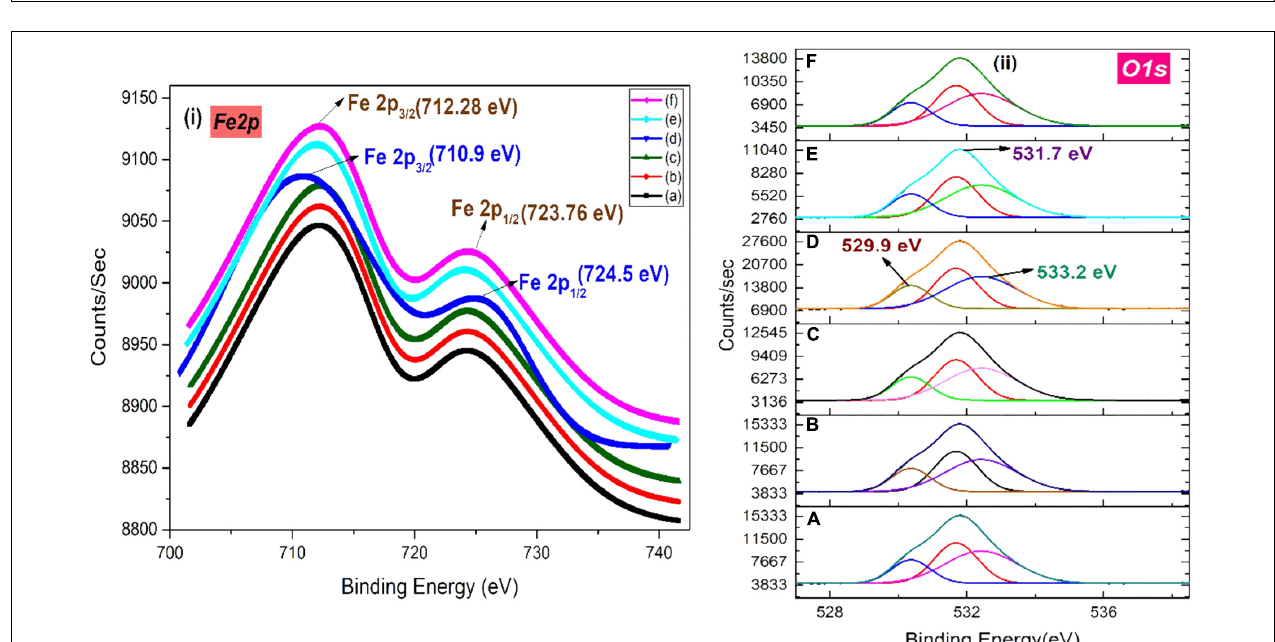
FIGURE 8 | XPS spectra of (i) Fe 2p and (ii) O 1s of green-synthesized IONPs by using (A) PJ, (B) WV, (C) PP, (D) BC, (E) AP, and (F) As extracts.